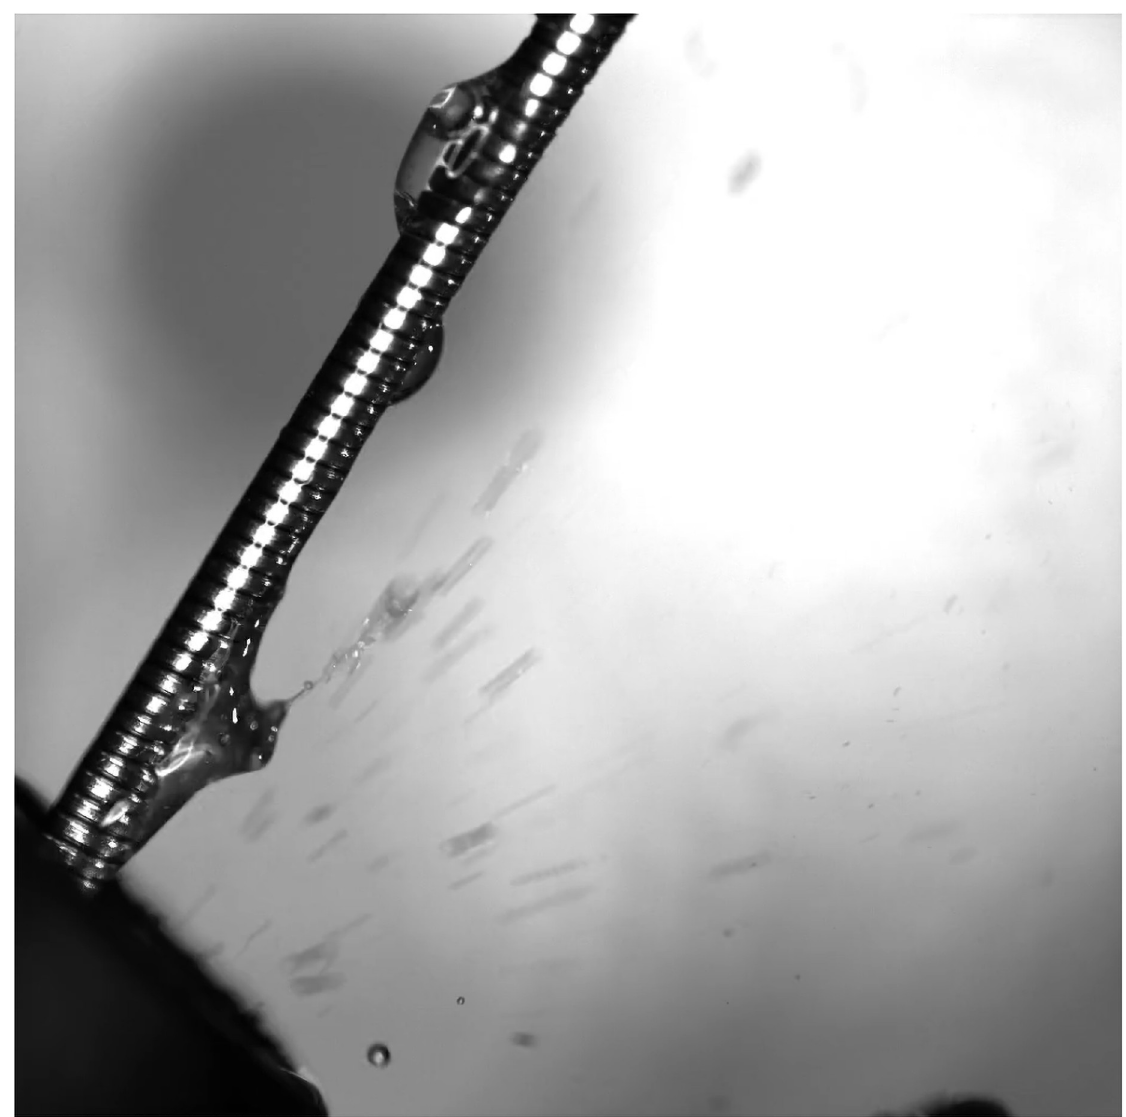
Fig 3. A release of fluid particles from the working channel of the endoscope. The picture shows generation and release of water droplets from the working channel of the endoscope when the forceps are inserted.